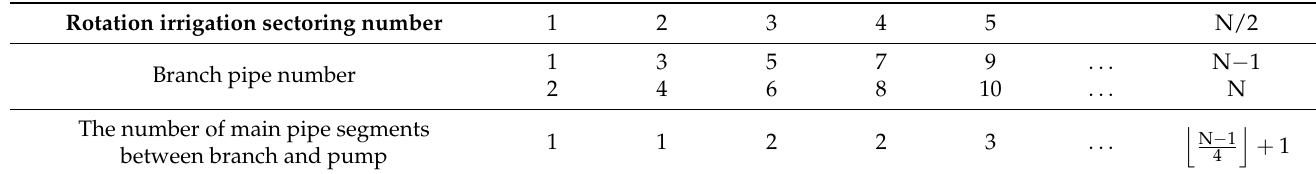
Figure 2. The schematic diagram of branch pipes number and main pipe segments number. Table 1. Rotation irrigation sectoring and the number of main pipe segments between branch pipe and pump.